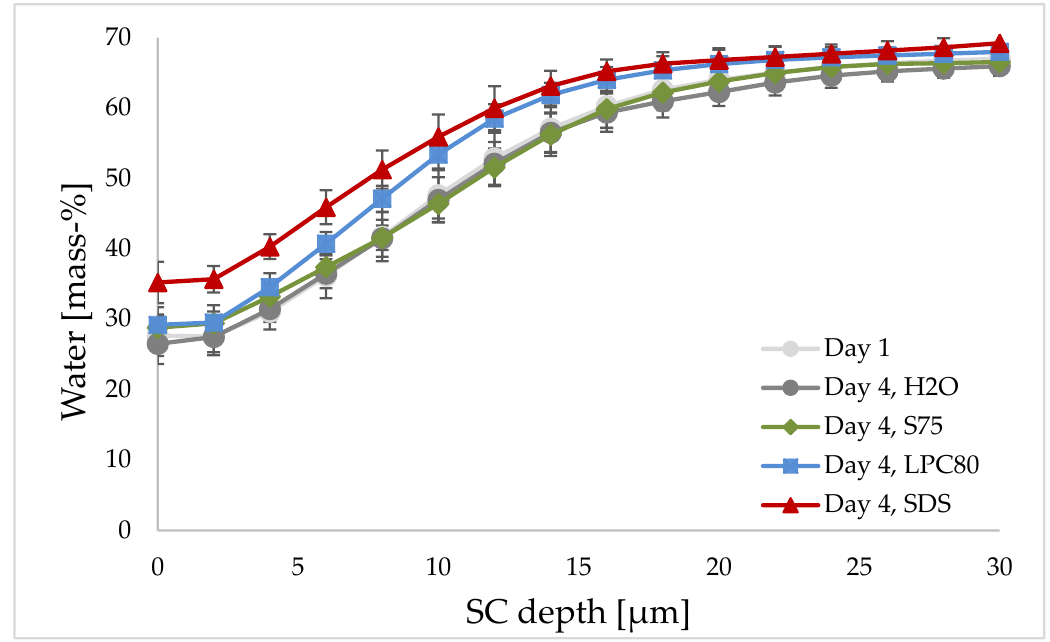
Figure 6. Effect of S75, LPC80, SDS and water as control on water concentration of human forearm skin in vivo as determined by CRS. Water concentration in mass-% is given at different SC depths before the treatment (day one, light grey) and after four days of repeated exposure (day four, H 2 O in dark grey, S75 in green, LPC80 in blue and SDS in red). Values are means of n = 8 ± SD.